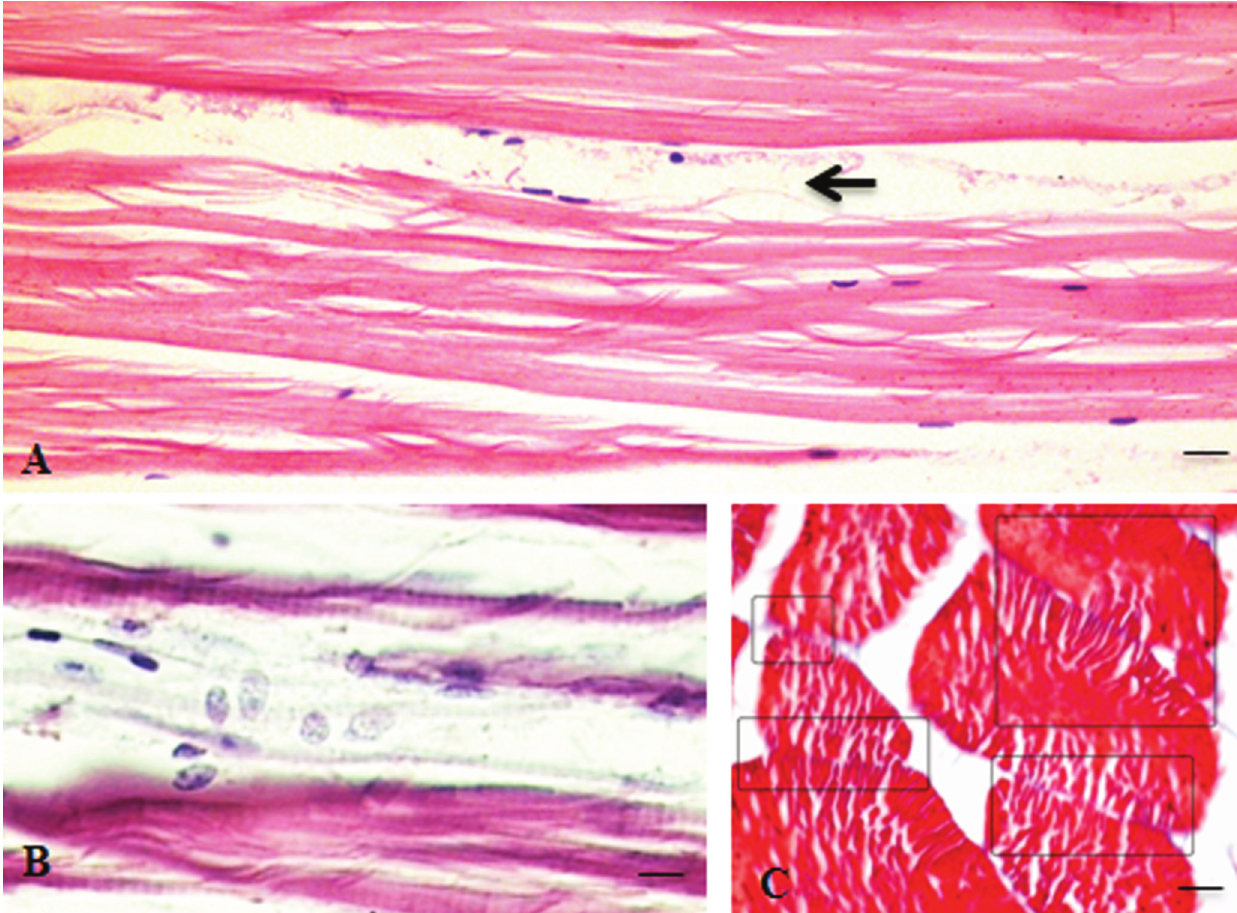
Fig. 2. A . Young muscle fibers running up. Cytoskeleton and nuclei (arrow). Longitudinal section. HE. (Bar = 50 μm ). B . Detail cytoskeleton during fusion of the muscle fiber. Longitudinal section. HE. (Bar = 25 μm ). C . Fusion side of young fibers (square). Transverse section. Masson trichrome. (Bar = 25 μm ).